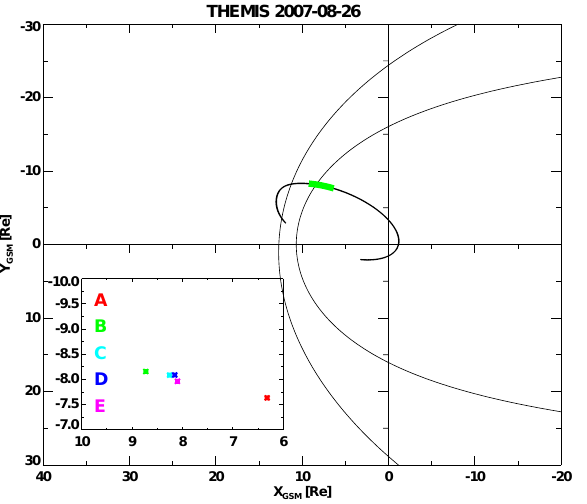
Fig. 2. Projections of THEMIS spacecraft orbits onto the equatorial plane with nominal locations of the bow shock (Jerab et al., 2005) and the magnetopause (Shue et al., 1998). An enlarged view of THEMIS separations is inserted into the bottom part of the figure.